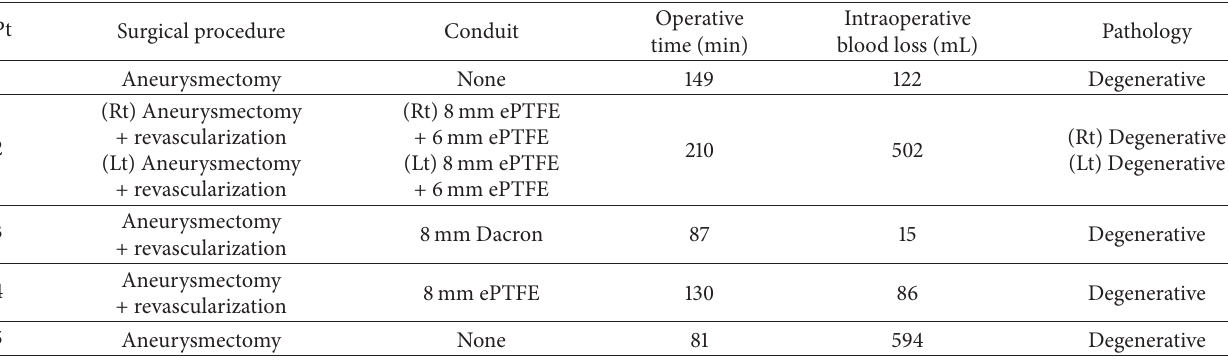
Table 3: Postoperative and long-term follow-up results.